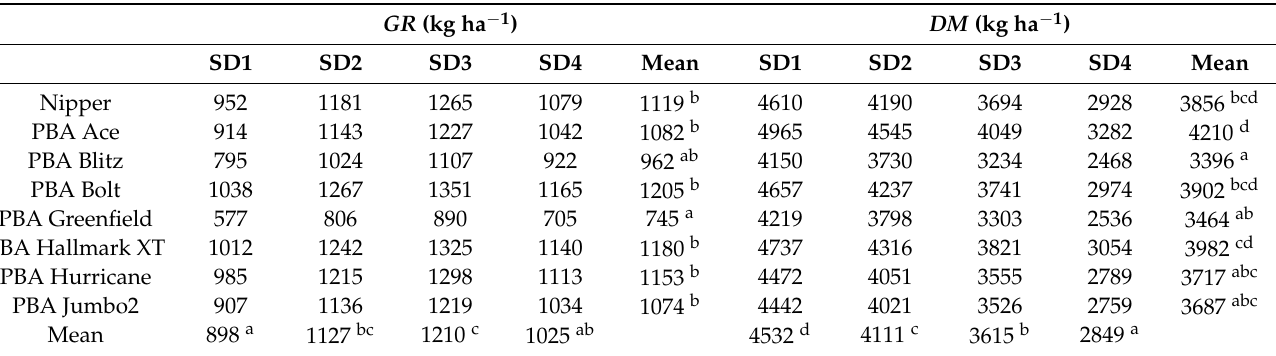
Table 5. Calculated values of grain yield ( GR ) and dry matter (biomass) accumulation ( DM ) from the fitted linear mixed models. Different letters indicate significantly different values. The values for the genotypes at each sowing date (SD) are the means of three